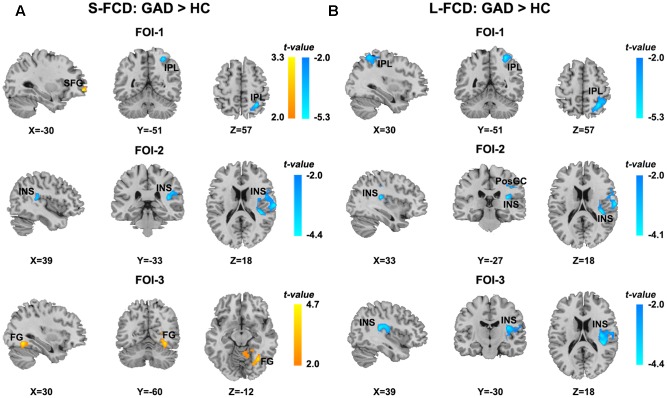
Statistical differences of frequency-specific FCD between two groups. (A) Statistical differences of S-FCD between two groups in three frequency-specific bands. (B) Statistical differences of L-FCD between two groups in three frequency-specific bands. The color bar indicates the t-values, which represent increased (warm) and decreased (cool) S-FCD and L-FCD in the GAD patients compared with HCs. Two sample t-test, significant level was set at P < 0.05, with AlphaSim corrected. The left hemisphere is on the left.